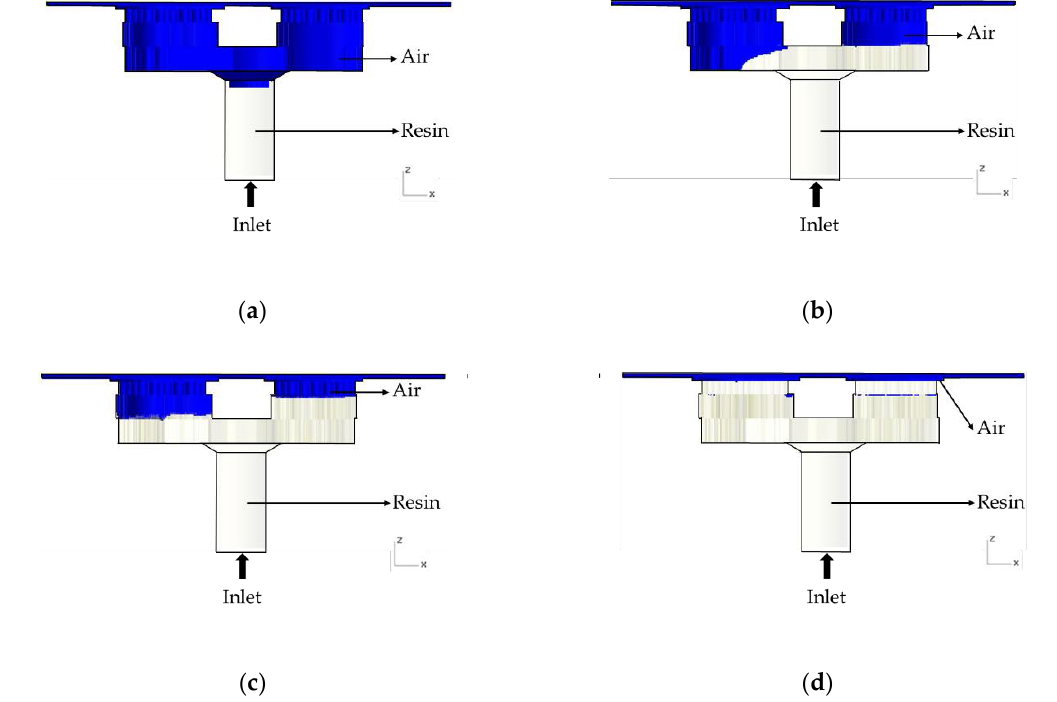
Figure A4. The flow rate is 0.04 cm 3 /s. ( a ) Filling 10%; ( b ) Filling 30%; ( c ) Filling 50%; ( d ) Filling 70%.